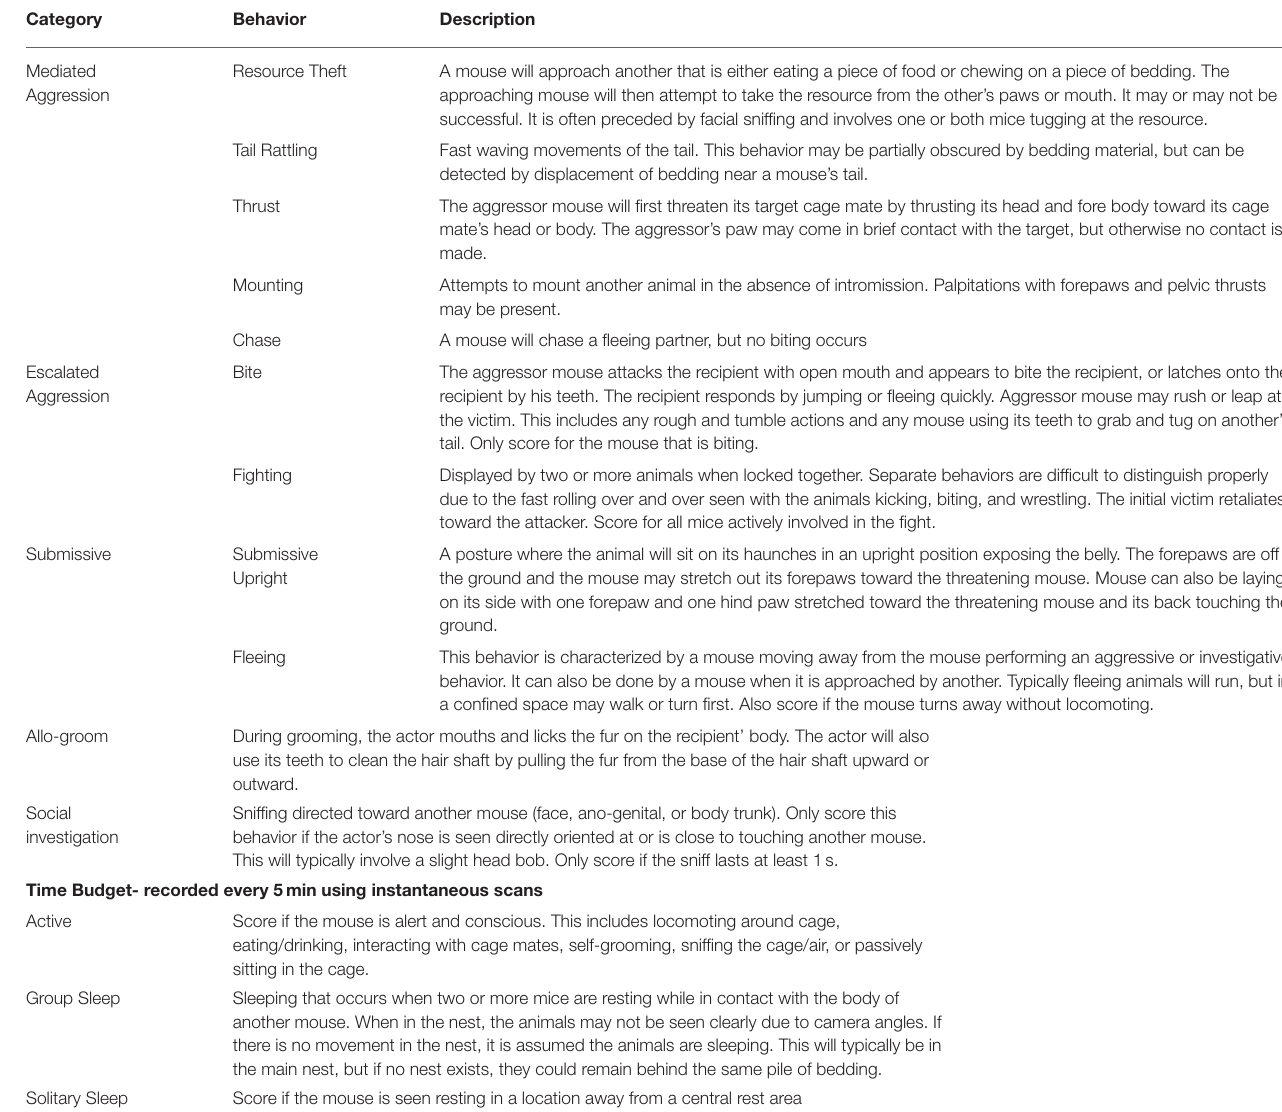
TABLE 1 | Ethogram of observed behavior